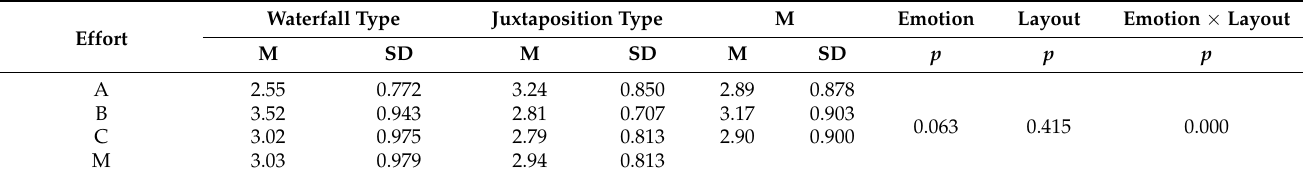
Table 5. Descriptive statistics and two-way ANOVA for effort in the